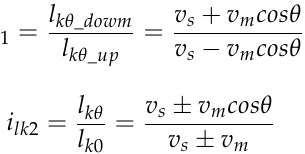
(c) Figure 7. Effects of v s and θ on 𝑖 (cid:3039)(cid:3038)(cid:2869) and 𝑖 (cid:3039)(cid:3038)(cid:2870) : ( a ) effects of v s and θ on 𝑖 (cid:3039)(cid:3038)(cid:2869) ; ( b ) effects of v s and θ on 𝑖 (cid:3039)(cid:3038)(cid:2870) in up-grinding; ( c ) effects of v s and θ on 𝑖 (cid:3039)(cid:3038)(cid:2870) in down-grinding. It can be found in Figure 6a: when there is angle θ , 𝑖 (cid:3039)(cid:3038)(cid:2869) will gradually increase along with the increase in v m , and its variation range is about 12%; this difference will be slightly reduced along with the increase in angle θ . It can be found in Figure 6b,c: whether the grinding wheel is in down-grinding or up-grinding, 𝑖 (cid:3039)(cid:3038)(cid:2870) changes monotonically along with the increase in v m , and obviously along with the increase in angle θ , but the value has no obvious change. It can be found in Figure 7a: when there is angle θ , 𝑖 (cid:3039)(cid:3038)(cid:2869) will gradually decrease along with the increase in v s , and its variation range is about 20%. With the in- crease in angle θ , this difference will be slightly reduced. It can be found in Figure 7b,c: whether the grinding wheel is in down-grinding or up-grinding, 𝑖 (cid:3039)(cid:3038)(cid:2870) changes monoton- ically along with the increase in v s , but the change trend gradually decreases, and it changes obviously along with the increase in angle θ . From the above analysis, it can be seen that the increase in v s and angle θ will appro- priately reduce the difference (ratio 𝑖 (cid:3039)(cid:3038)(cid:2869) reduces) of the kinematic contact arc length in up-grinding and down-grinding, while the effect of v m is opposite. When the grinding wheel is in up-grinding, the increase in angle θ and v m will slightly increase the difference of the kinematic contact arc length of the grinding wheel (ratio 𝑖 (cid:3039)(cid:3038)(cid:2870) decreases), but the 10